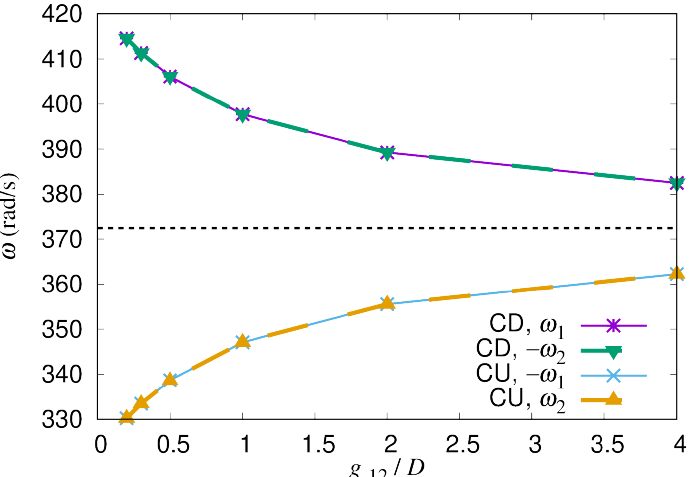
Figure 9. The angular velocity in the phase-synchronized steady state is plotted against the gap g 12 / D . The dashed line around ω (cid:39) 372rad/s shows the angular velocity at the steady state without the mutually induced